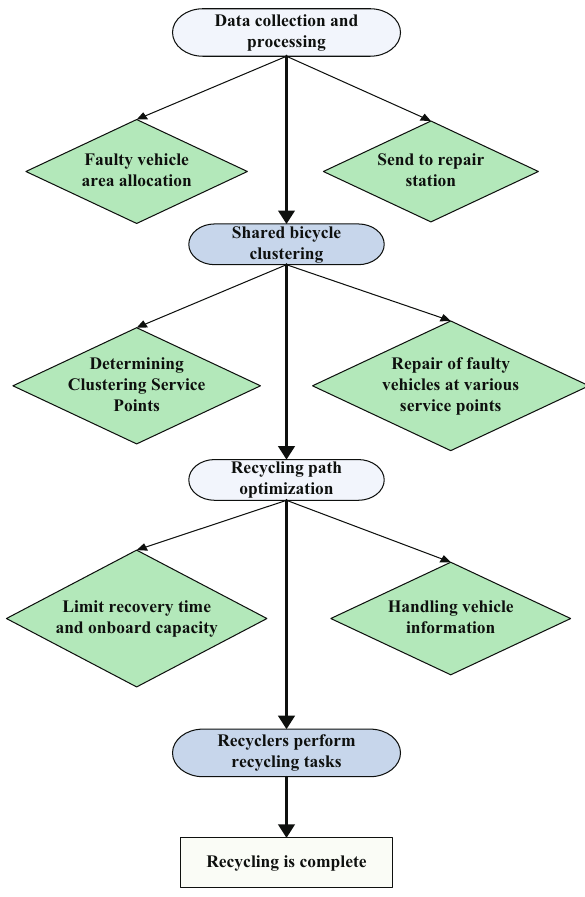
Figure 3: The recovery process of shared bicycles with faulty